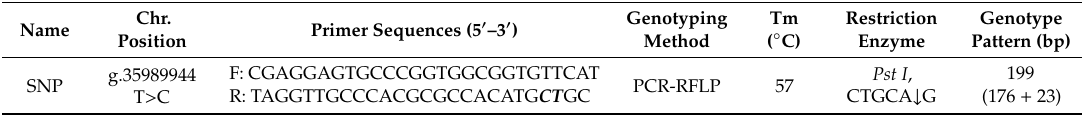
Table 1. Polymerase chain reaction (PCR) primer sequences and approach for the identification of single-nucleotide polymorphism (SNP) in KCNJ12